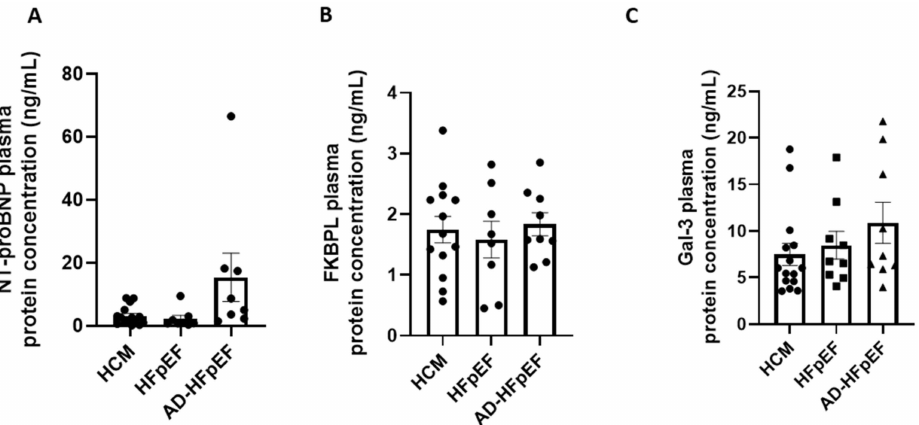
Figure 5. Biomarker plasma protein concentrations in subgroups of HFpEF. Patients were divided into subgroups based on HFpEF symptoms, HCM ( n = 15), chronic HFpEF ( n = 9) or acute decom- pensated HFpEF ( n = 9). ( A ) NT-proBNP plasma concentration of HFpEF subgroups measured by ELISA. ( B ) FKBPL plasma concentration of HFpEF subgroups measured by ELISA. ( C ) Gal-3 plasma concentration of HFpEF subgroups measured by ELISA. Results expressed as Mean ± SEM, One-way ANOVA with Tukey’s post-hoc. HCM—hypertrophic cardiomyopathy; HFpEF—chronic heart failure with preserved ejection fraction; AD-HFpEF—acute decompensated HFpEF.